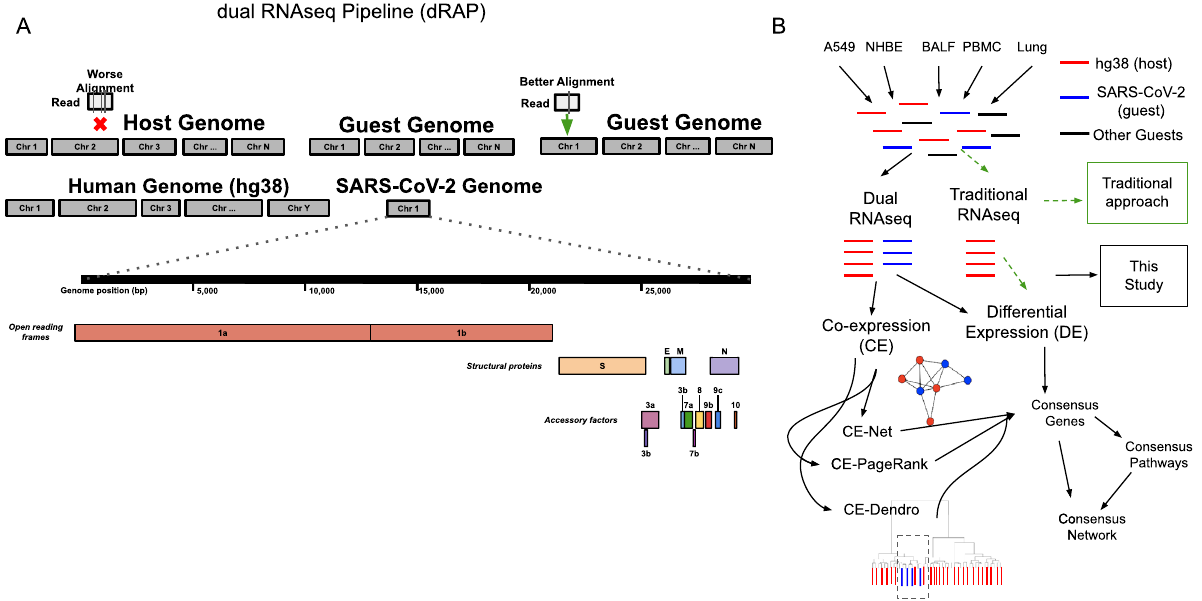
Figure 1. ( A ) Illustration of the dual RNAseq alignment pipeline (dRAP) using both host and guest genomes. Dual RNAseq creates a single reference index for RNAseq read alignment with STAR by appending “guest” genomes to the host genome allowing for simultaneous alignment of reads with multiple transcriptomes where the best overall alignment is selected. An example is shown where dRAP can resolve that a single read has a better match to the guest genome with only 1 mismatch (green arrow) compared to the host genome with 3 mismatches (red vertical lines). The SARS-CoV-2 guest genome (NC_045512v2) is depicted with its annotated set of genes designated as open reading frames, structural proteins, or accessory factors. ( B ) Overview of dRAP application to SARS-CoV-2 analysis enabling the detection of coexpression associations between transcripts originating from human (red lines) and virus (blue lines). RNAseq reads from SARS-CoV-2 infected samples from human cell lines (A549 and NHBE) and patients (BALF, PBMC, and Lung) were collected from public datasets (Blanco-Melo et. al. 2020 and Xiong et. al. 2020). Traditional RNAseq (dashed green arrows), which does not quantify both human and viral transcripts, allows for only differential expression analysis, while dRAP (black arrows) enables both downstream differential and coexpression analyses between host and virus. A549, NHBE, and BALF samples were selected for downstream analyses as they contained SARS-CoV-2 transcripts. Several co-expression analyses (CE) were performed in linear (CE-Net) and nonlinear (CE-dendro) relationships between the human and SARS-CoV-2 transcriptomes and genes of influence (CE-PageRank) in the gene regulatory network. Each CE view, along with DE, produced a set of results for A549, NHBE, and BALF groups. Genes implicated in two or more CE views were collected and used to determine enriched pathways (denoted “consensus pathways”). A “consensus network” was determined by including genes and pathways found by two or more